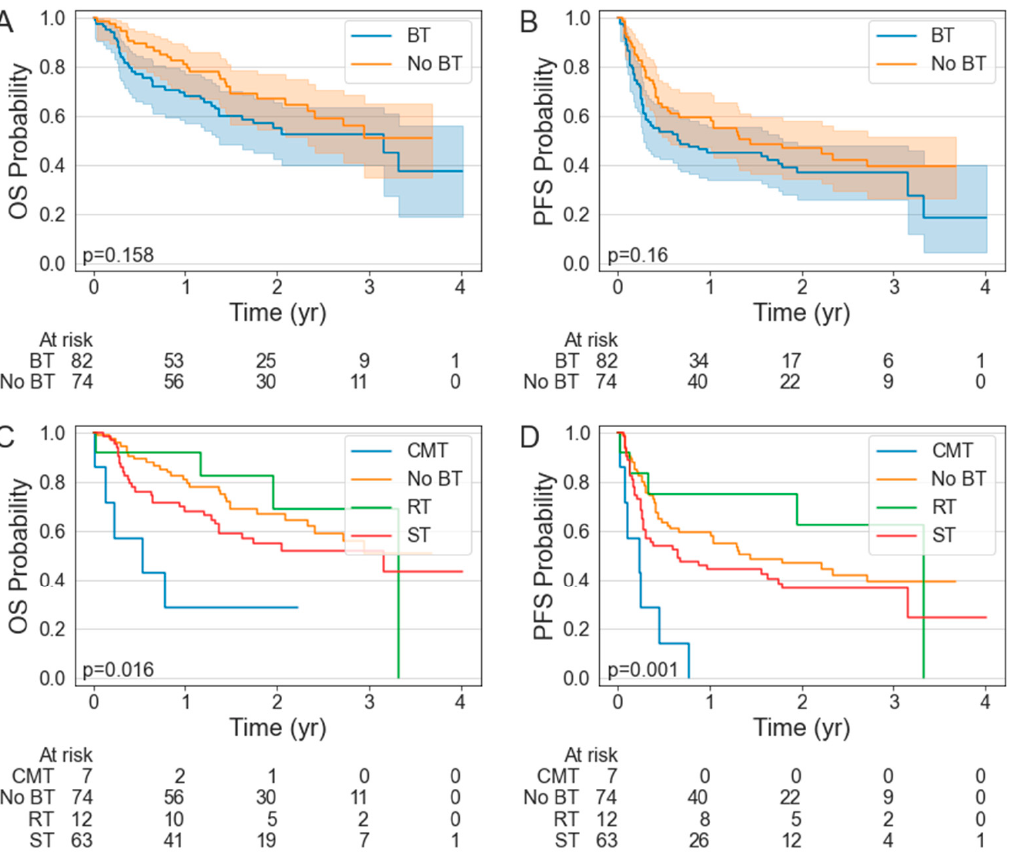
Figure 1. Kaplan–Meier estimates of overall survival ( A , C ) and progression-free survival ( B , D ) stratified by bridging therapy status.